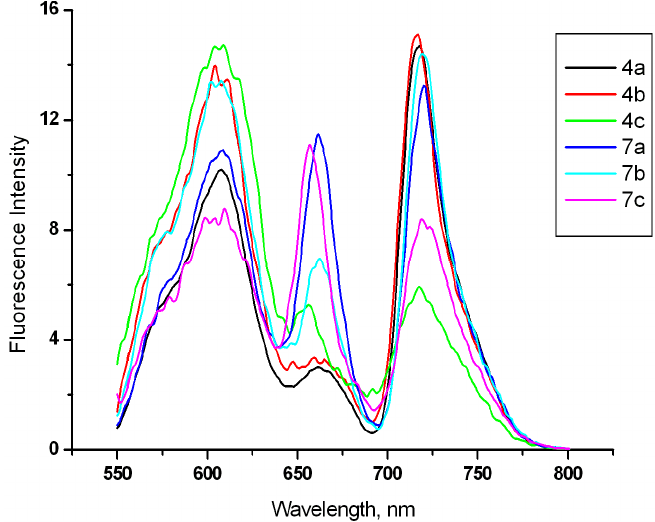
Figure 3. Fluorescence spectra of purpurinimides 4a – 4c and 7a – 7c (1.0 × 10 − 4 M) in dimethylsulfoxide